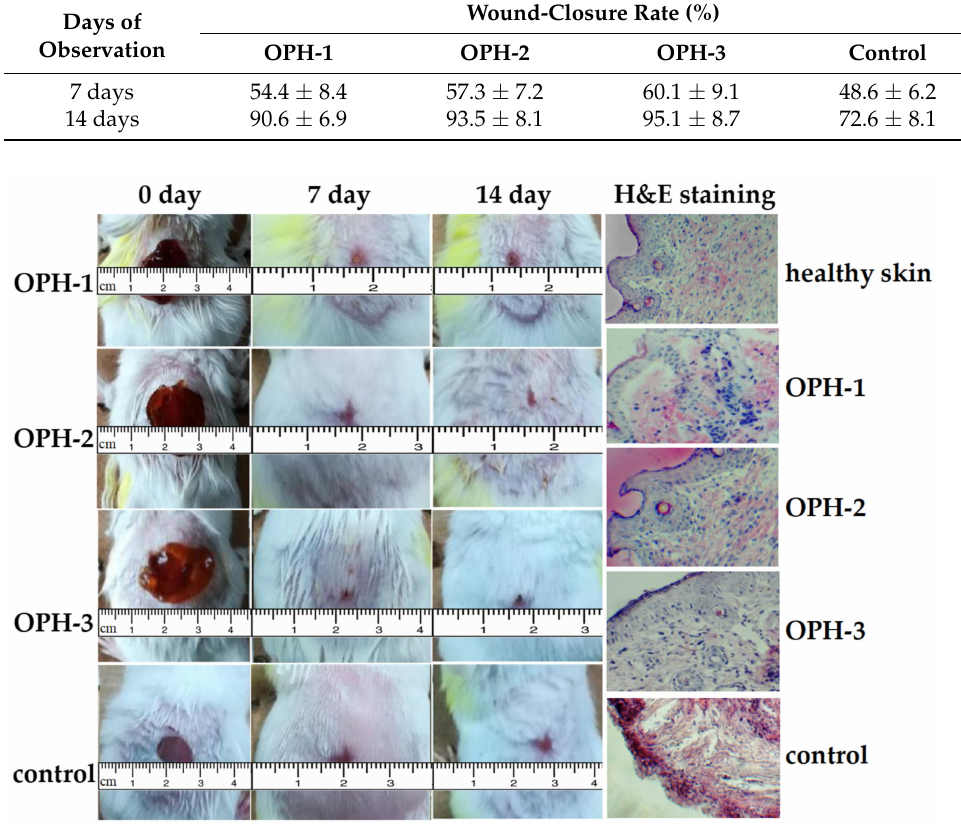
Figure 7. Photographs of wound healing and H&E staining for healthy skin, OPHs, and control (100 ×